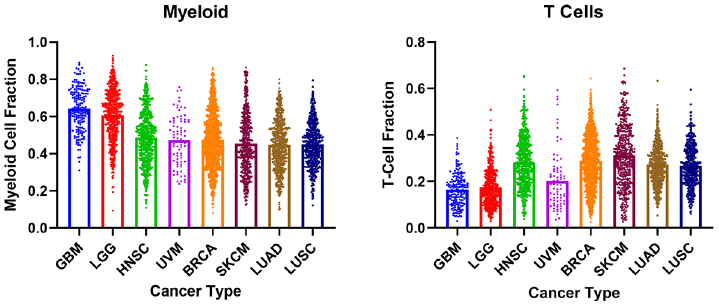
Figure 2. Analysis of CIBERSORT immune infiltration fractions in select cancer types. The myeloid and T cell populations in the TME were compared. Myeloid cells were defined as: Monocytes, Macrophages (M0, M1, M2), Dendritic Cells (Resting, Activated). T Cells were defined as CD8+, CD4+ (Na ï ve, Resting Memory, Activated Memory), FollicularHelper,and γδ .DatawasobtainedfromThorssonVet.al.Immunity2018.BRCA,BreastInvasiveCarcinoma; GBM, Glioblastoma; HNSC, Head and Neck Squamous Cell Carcinoma; LGG, Low Grade Glioma; LUAD, Lung Adenocarcinoma; LUSC, Lung Squamous Cell Carcinoma; SKCM, Skin Cutaneous Melanoma; UVM, Uveal